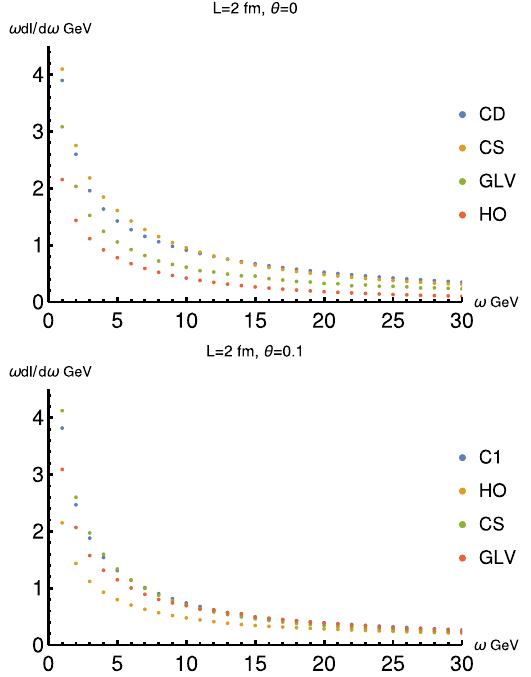
by Eq. 53. The curves CD and CS show the dependence of the total energy loss (HO + Coulomb) given by Eq. 53 on the parametrisation of the substruction momenta Q: CD corresponds to the parametrisation 56, CS to the parametrisation 57, see the discussion in Sect. 2.3. The curve GLV refers to N = 1 GLV expression with Q independent ˆ